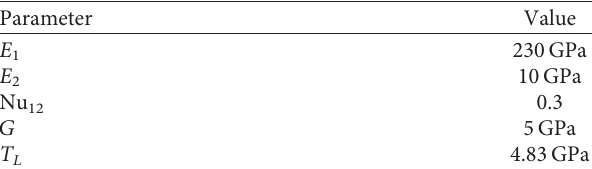
Table 2: Properties of